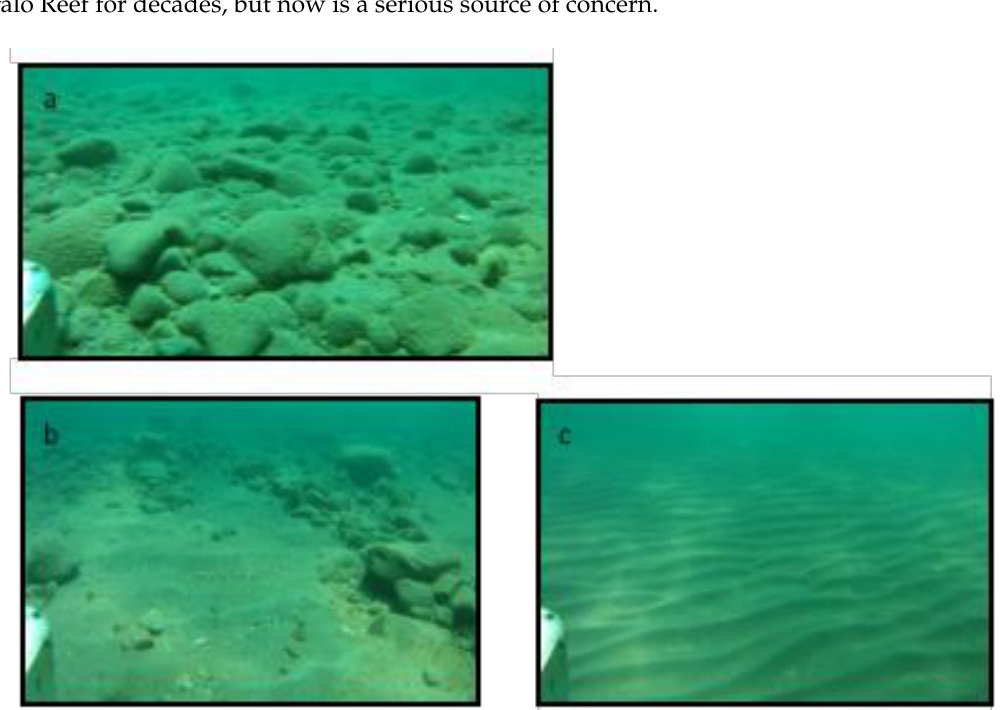
maximum erosion of − 30 inches ( − 76 cm, red) to positive deposition of + 54 inches ( + 137 cm; purple). Yellow to red regions indicate pronounced net erosion along the Gay Pile and Gay Pile to Coal Dock stretch (Regions 1 and 2; right red, brown and yellow zones). Green to dark blue regions mark